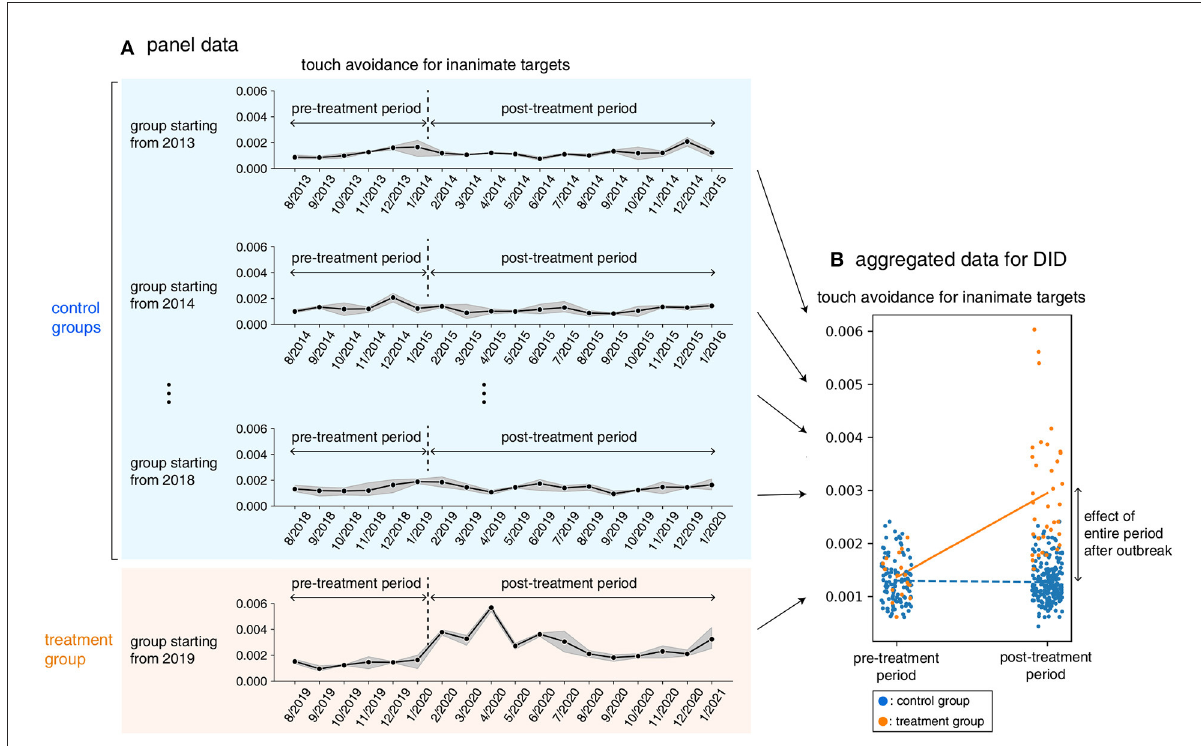
FIGURE2 (A) Panel data comprised seven groups that started between 2013 and 2019. The group that started from 2019 is referred to as the “treatment group” (orange panel). The groups that started from 2013 to 2018 are referred to as the “control groups” (blue panel). The data of each group comprise 18 months (from August in the first year to January in the third year). Each group has a pre-treatment period (from August in the first year to January in the second year) and a post-treatment period (from February in the second year to January in the third year). (B) The panel data was aggregated for the pre-treatment and post-treatment periods. The difference between post-treatment and pre-treatment was calculated for both treatment and control groups. The difference between the treatment and control groups in the difference between the post- and pre-treatment periods was regarded as the effect of the entire period after the COVID-19